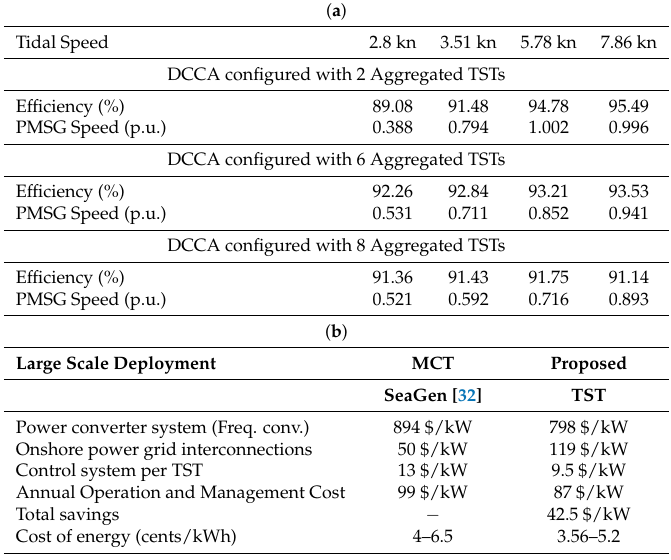
Table 2. ( a ) Dynamic influence on TST aggregate size for a single DCCA; ( b ) comparisons of installation costs’